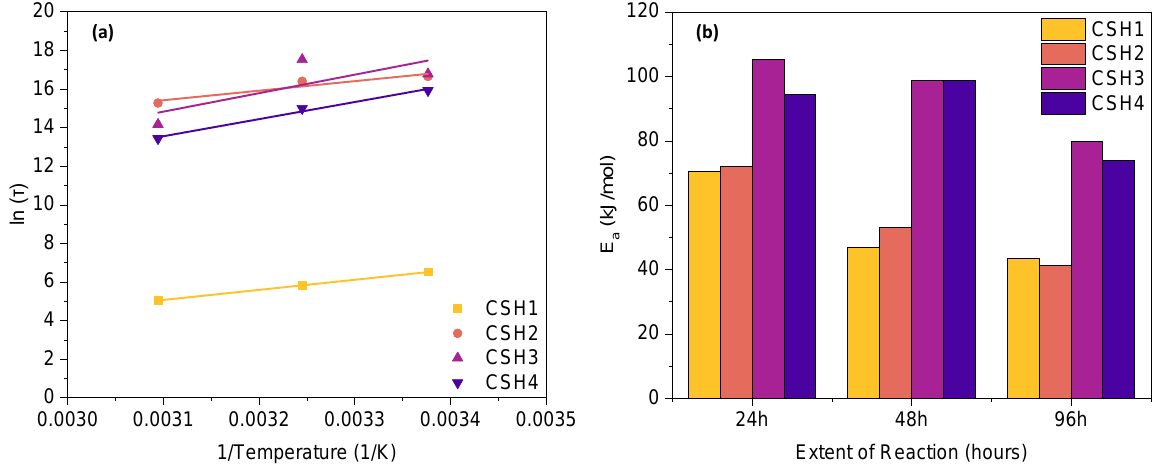
Figure 4. ( a ) Arrhenius plot at 96 h and ( b ) activation energy at different extent of reaction.